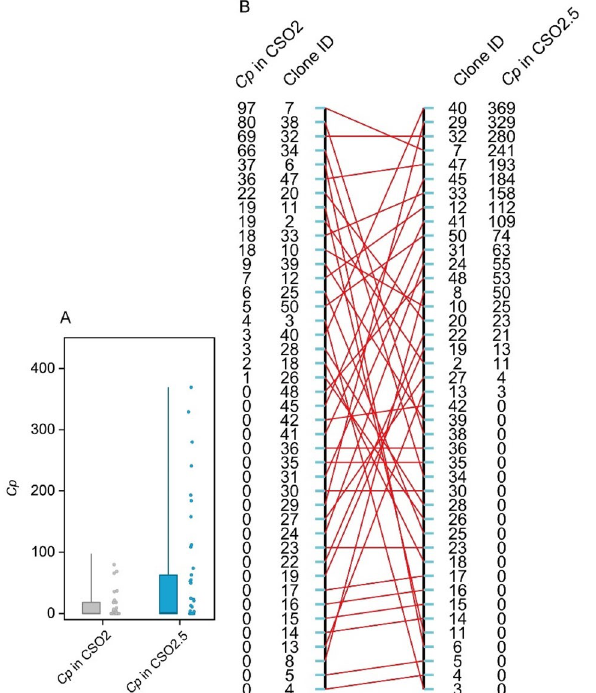
Figure 5. Variation of cone production in two generations seed orchards of Chinese fir. ( A ) The cone production for two seed orchards, ( B ) the rank order for 42 clones based on the cone production in two seed orchards. Cp cone production.